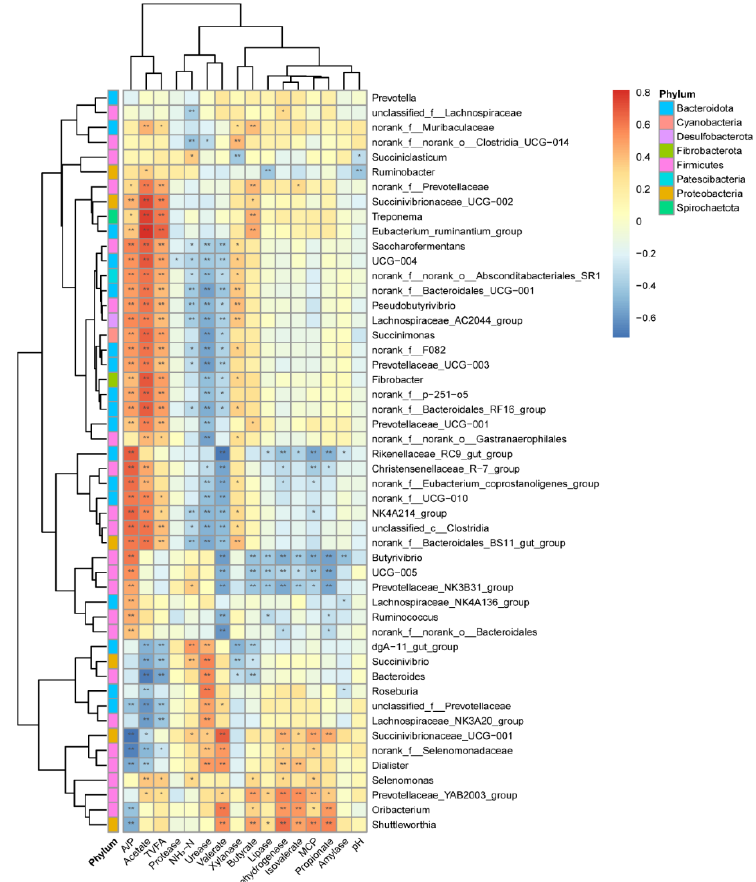
Figure 4. The correlation between bacteria (genus level) and their byproducts. Cells are colored based on Spearman’s correlation coefficient: red represents a positive correlation, and blue represents a negative correlation. “*”, and “**”, indicate FDR (false discovery rate) adjusted p -values <0.05 and <0.01, respectively. NH 3 -N: ammonium nitrogen; MCP: microbial crude protein; VFA: volatile fatty acid; TVFA: total volatile fatty acid; A/P: the ratio of acetate to propionate. The Spearman’s correlation coefficient of the top 50 genera with age or diet is in Table S3. We selected five bacteria genera highly correlated with age and diet and correlated